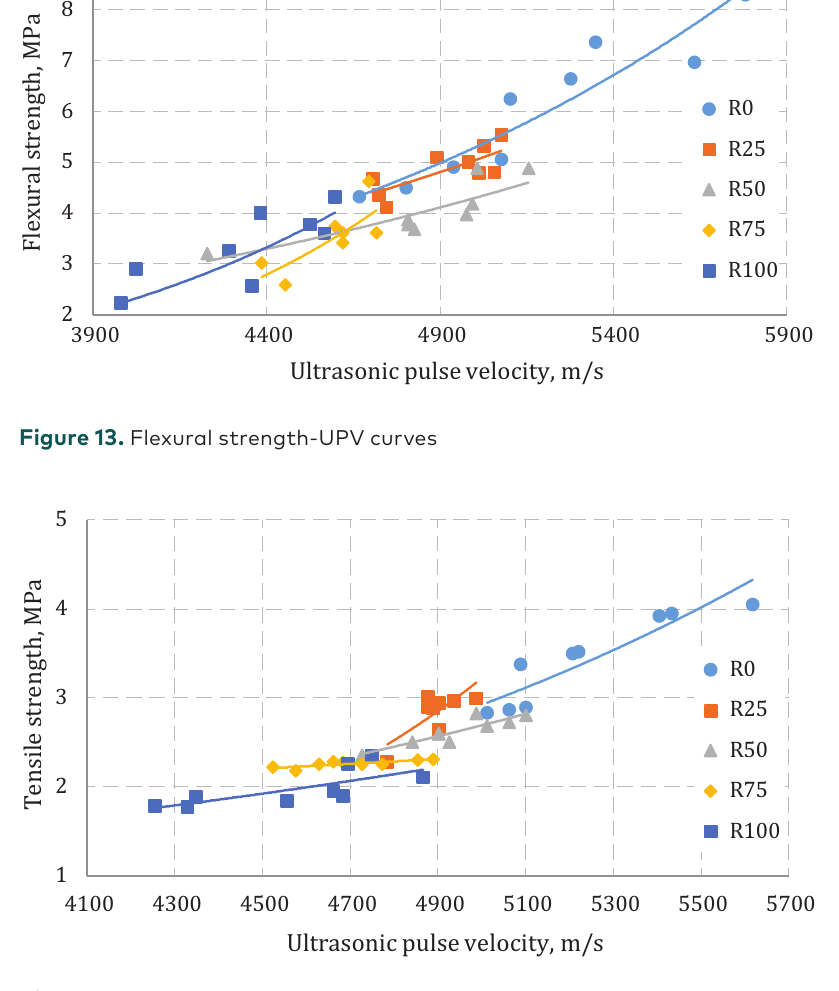
Figure 14. Tensile strength-UPV